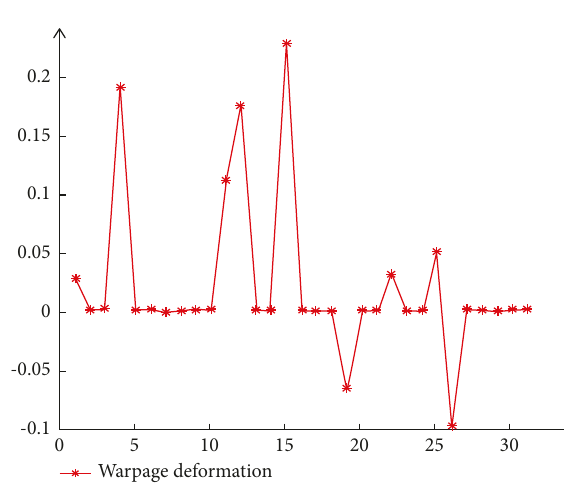
Figure 27: Optimized Warpage error diagram.